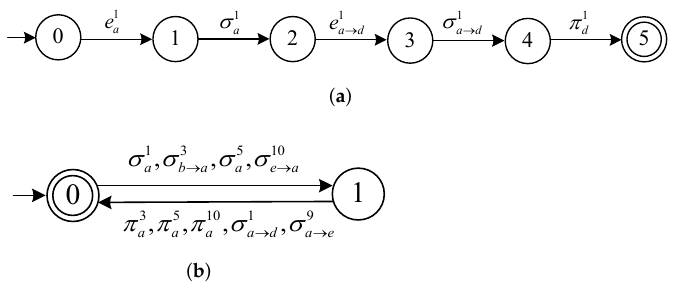
Figure 7. Automata P 1 and R a ; ( a ) Automaton P 1 for Process 1; ( b ) Automaton R a for Resource a